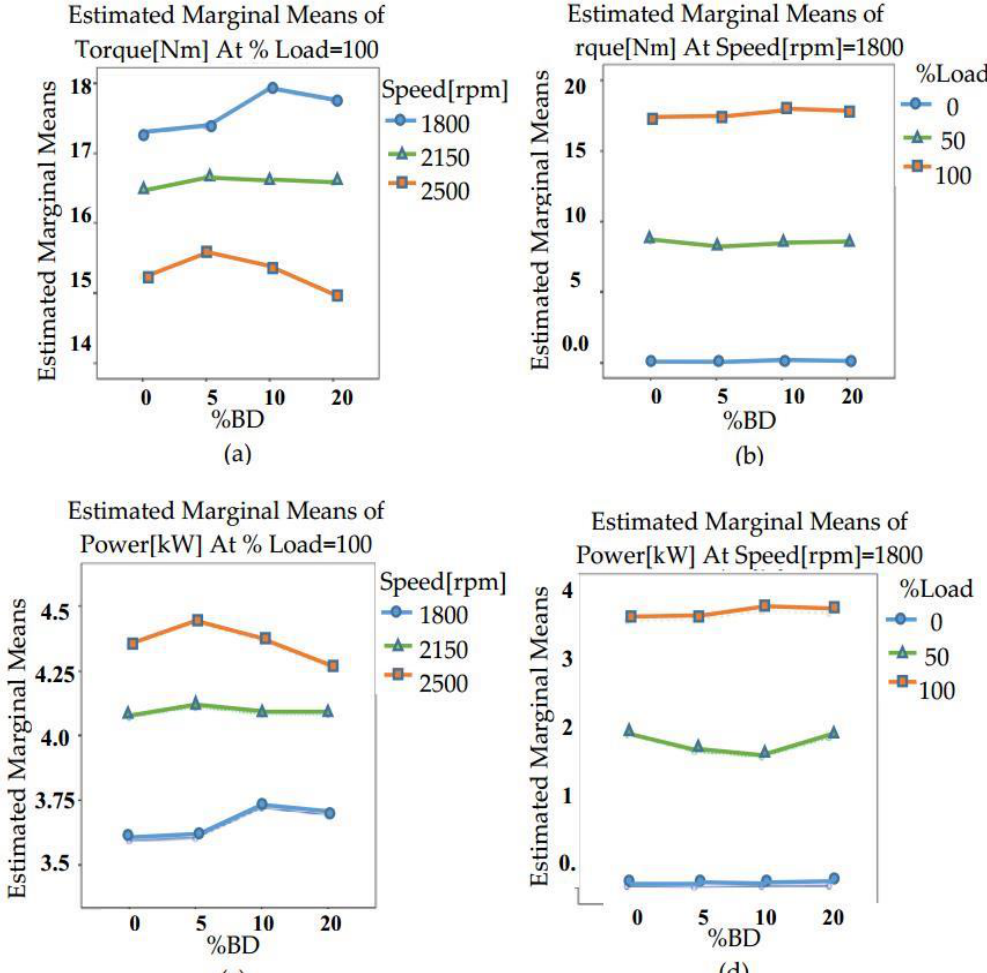
Figure 3. Torque ( a , b ) and power ( c , d ) changes at constant load and engine speed.